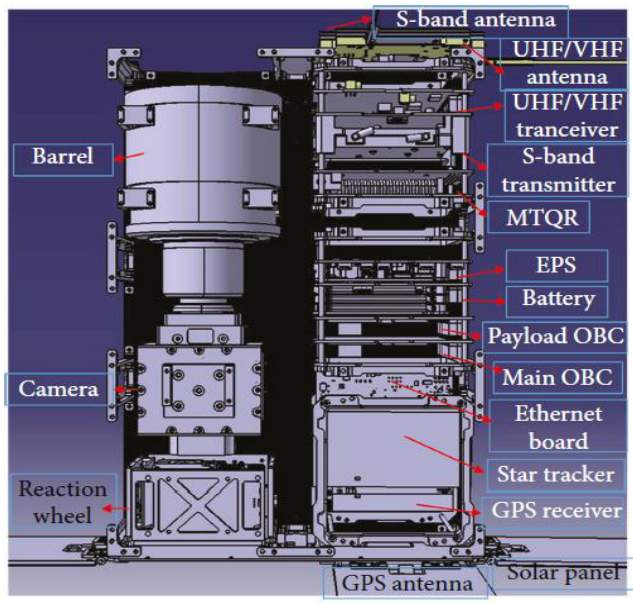
Figure 2. HiREV 6U Nanosatellite Subsystem [20] .